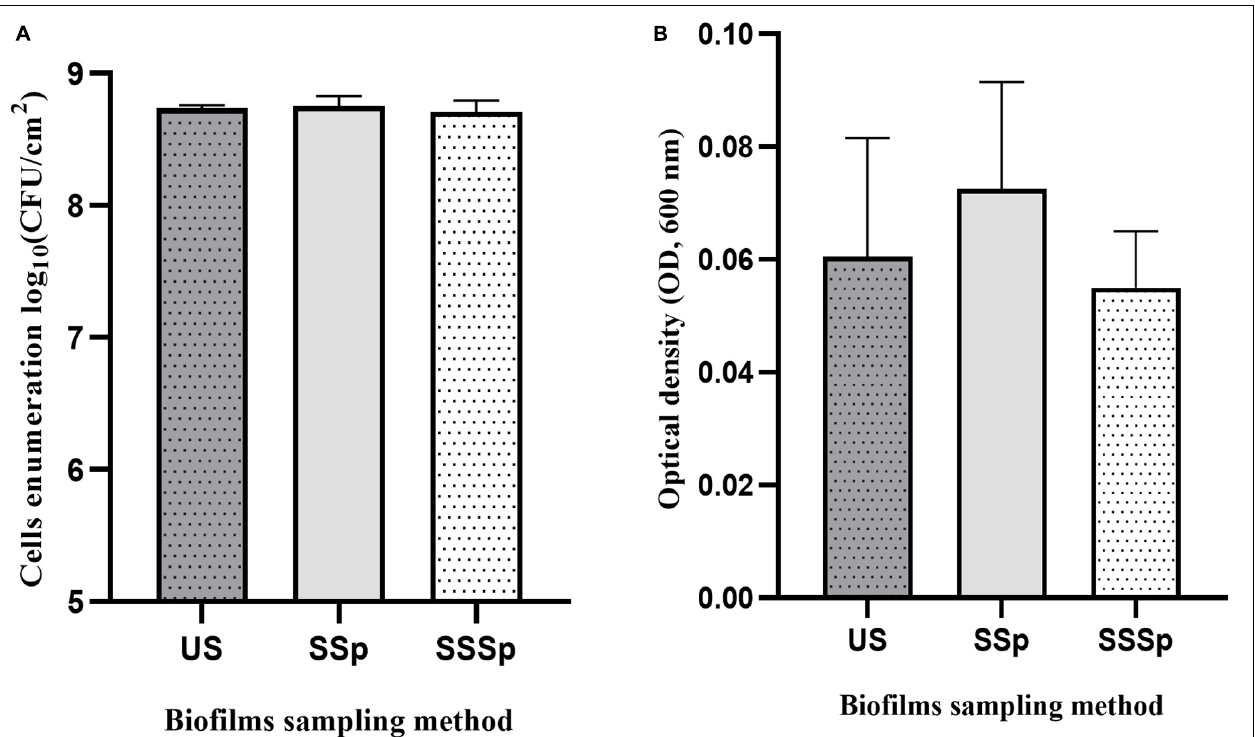
FIGURE 4 | Recovery of P. azotoformans Pfl1A cells from biofilm grown on stainless-steel slides in TSB medium, determined by enumeration (A) and by measuring optical density at 600 nm (B) . Ultrasonication method (US); Synthetic sponge (SSp); Sonicating synthetic sponge (SSSp). Values are mean ± SD ( n = 3). Differences are not significant (ns, p > 0.05), based on one-way ANOVA and Dunnett’s multiple comparison